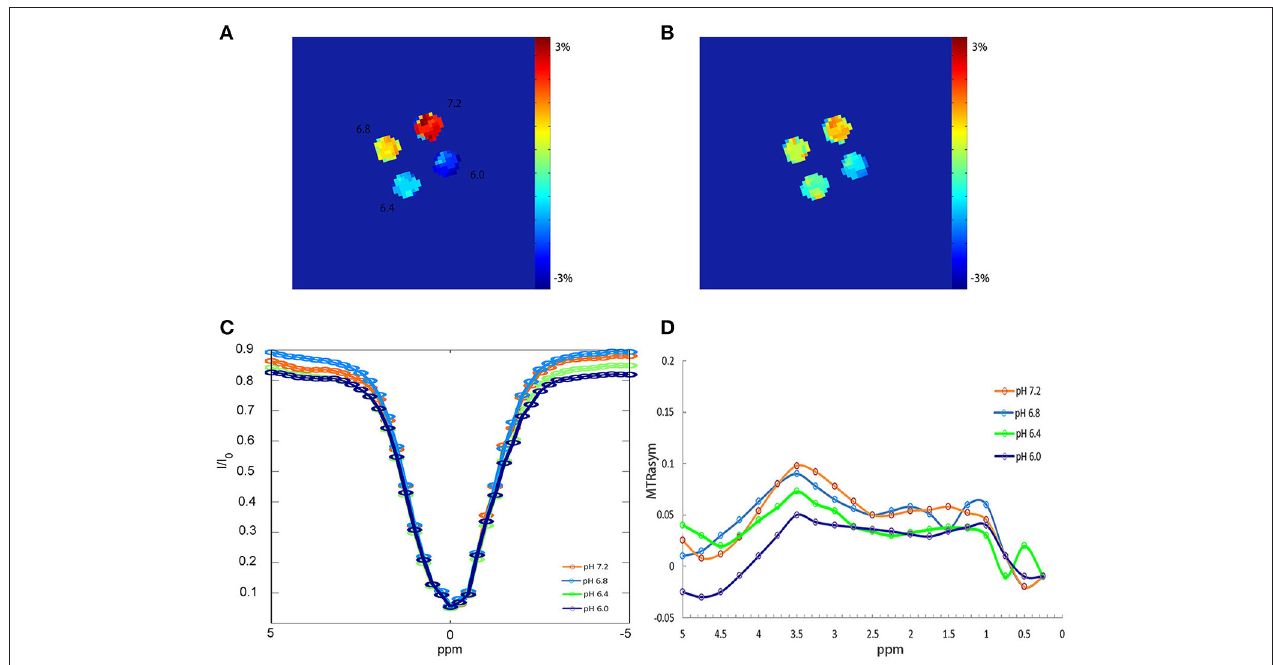
FIGURE 2 | APTW imaging, Z spectra and MTRasym curves of BSA phantoms. (A) APTW imaging of 4 20% BSA phantoms with difference pH (6.0, 6.4, 6.8, 7.2) measured at a width of 40ms, a flip of 340 ◦ , duty cycle of 50% and the number of saturation pulse of 50. (B) APTW imaging of 4 different pH BSA phantoms measured at a width of 40ms, a flip of 180 ◦ , duty cycle of 50%, and the number of saturation pulse of 50. (C,D) Z spectra and MTRasym curves of 4 different pH BSA phantom measured with a flip of 340 ◦